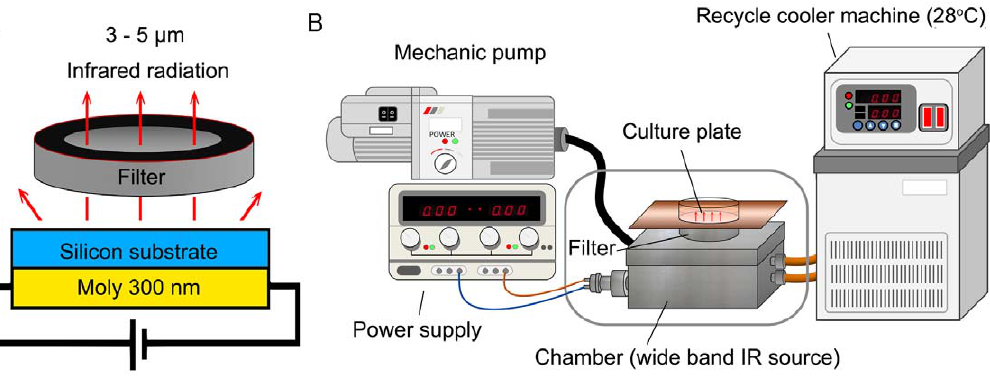
Figure 1. The MIR emitter. (A) The side view of wide band blackbody source. (B) Schematic diagram showing the setup for the MIR irradiation experiment. The cells were plated onto 12-well plates and cultured in an incubator with 100% humidity, at 37 u C and with 5% CO 2